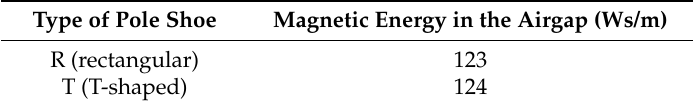
Table 6. Magnetic energy in the airgap for Y40 when using different pole shoe designs. Type of Pole Shoe